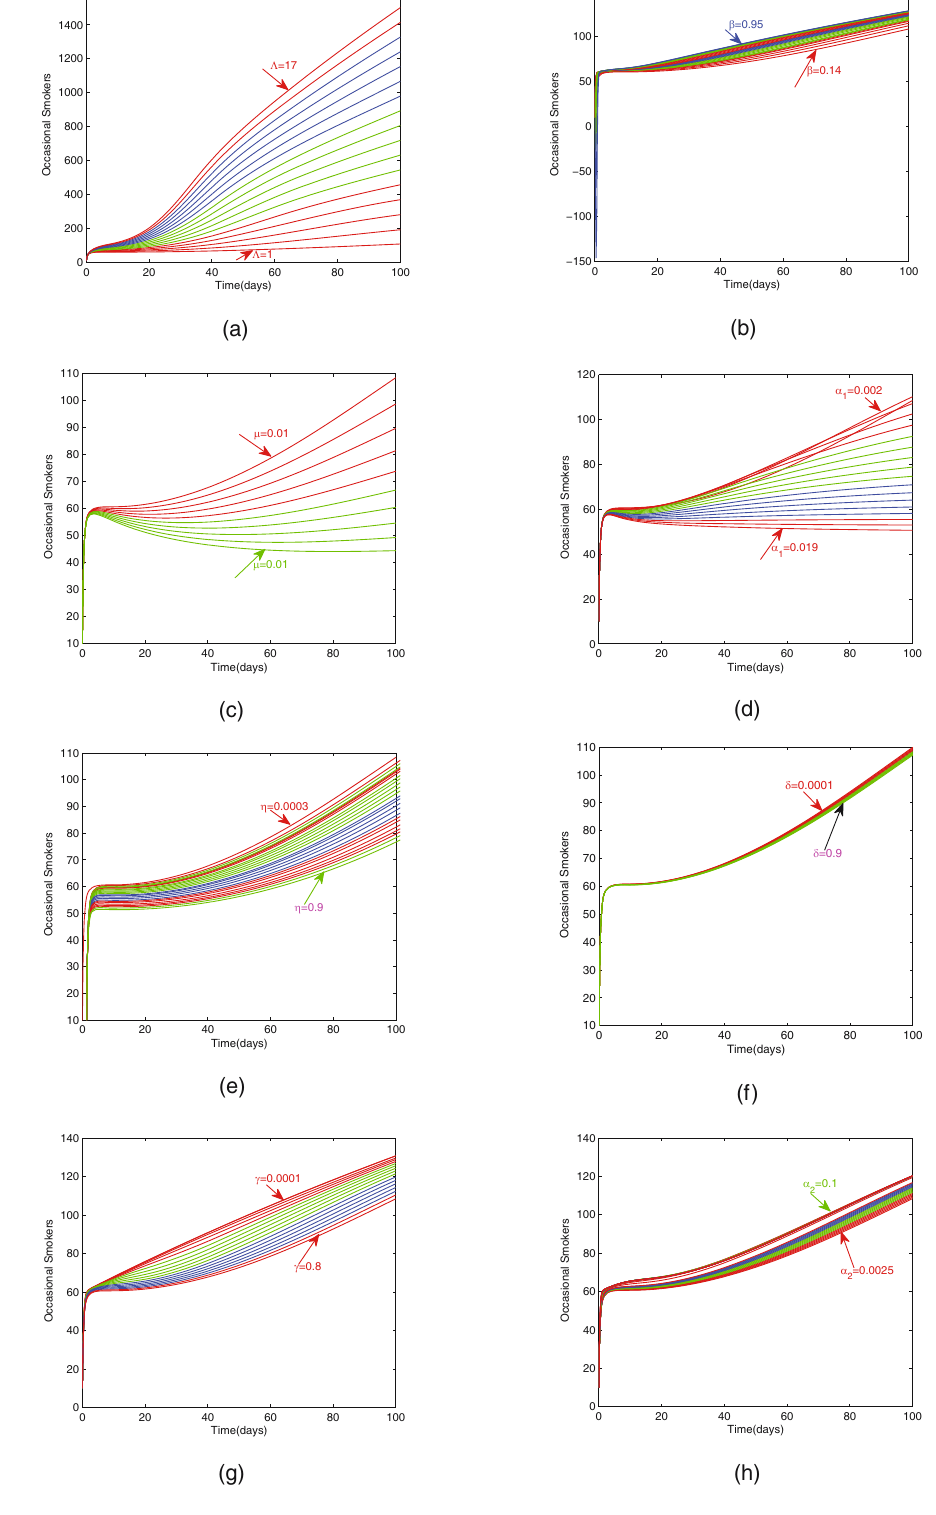
Figure 4: Variation in the endemic level of O ∗ ( from a – h ) with respect to model